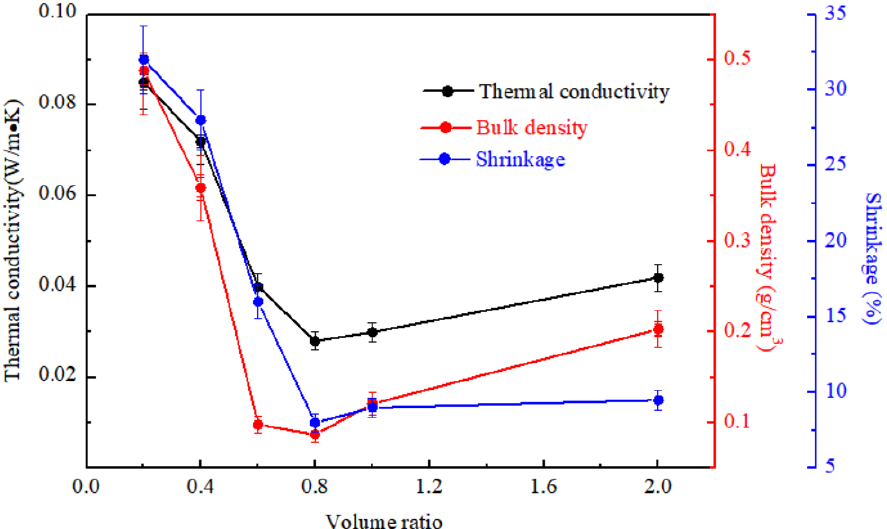
Figure 2. The variation in thermal conductivity, bulk density and shrinkage of the VF-SiO 2